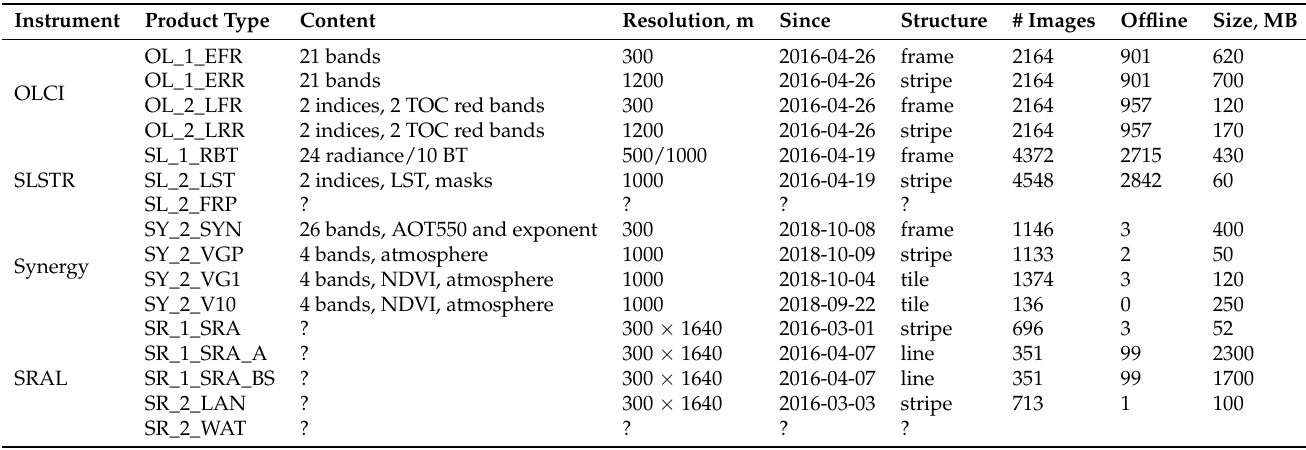
Table A1. Sentinel-3 products availability from the Since date to 23 September 2020: Level 1—top of atmosphere, level 2—